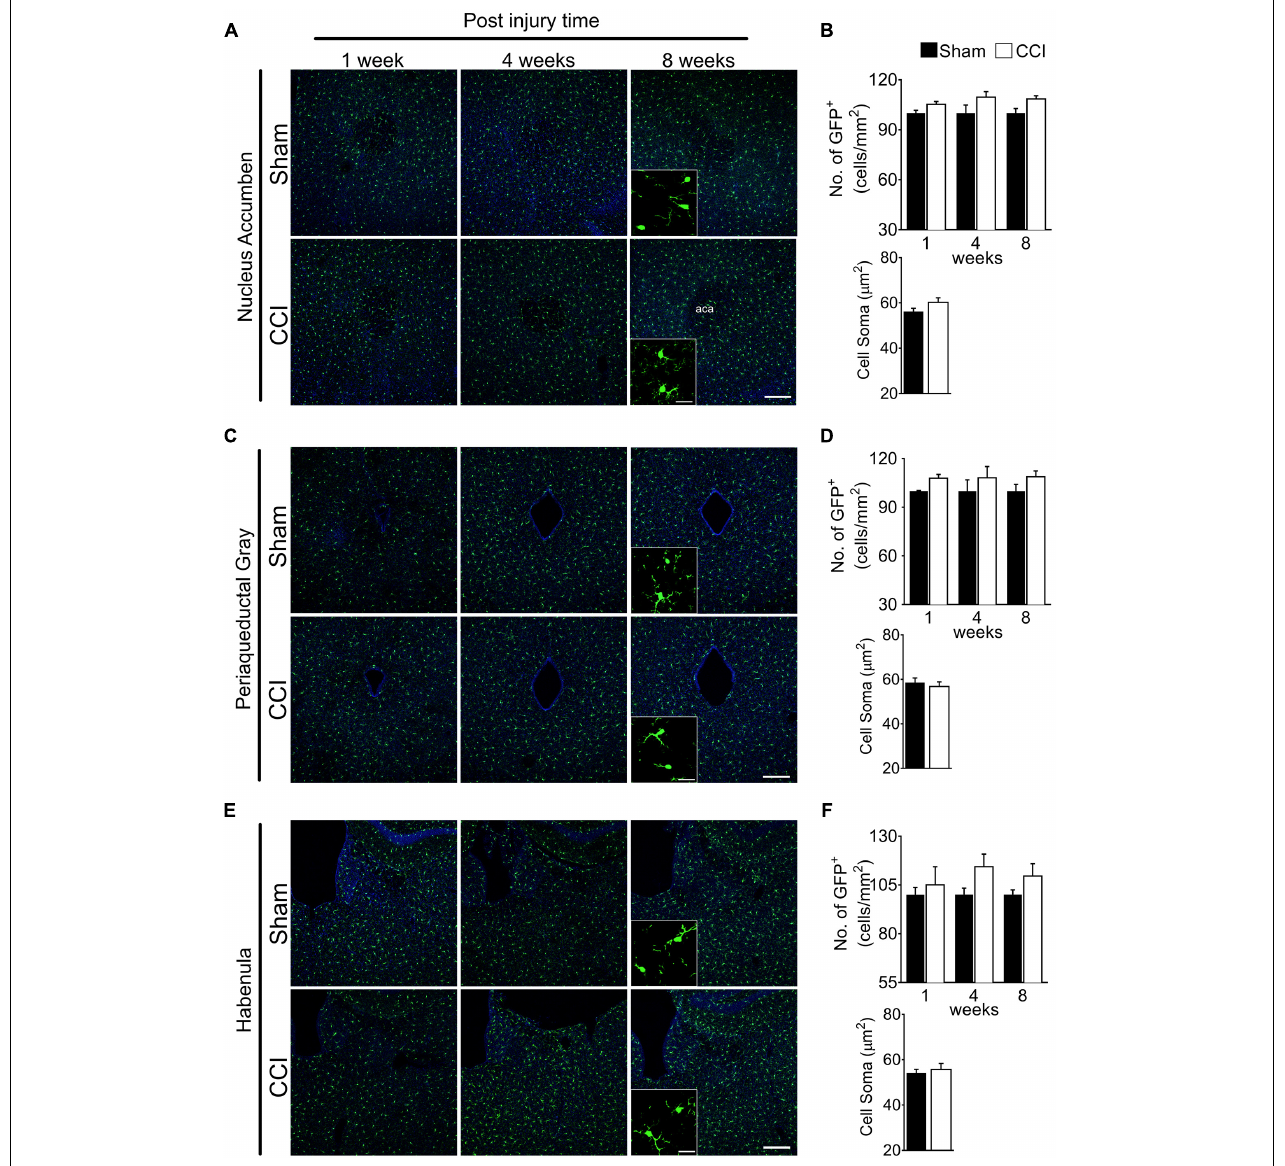
FIGURE 4 | CCI did not show obvious changes of microglial morphology in the nucleus accumbens, periaqueductal gray, or habenula at any of the time points investigated. Representative images of the (A) nucleus accumbens, (C) periaqueductal gray, (E) habenula, and a high magnification image taken at 8 weeks post-injury (inset) are shown, along with (B, D, F) the areas of quantification of microglial cell number ( n = 5, 3–4 tissue sections per animal, mean ± SEM) at 1, 4, and 8 weeks and soma area ( n = 5, 3–4 tissue samples per section, 40 microglial cells, mean ± SEM) at 8 weeks post-injury showing no significant differences between the CCI group and sham group. Scale bar: 100 µ m. Inset scale bar: 100 µ